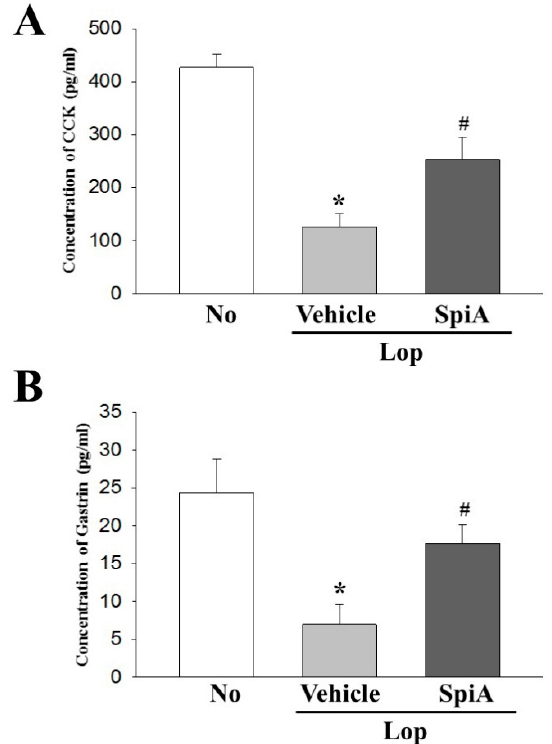
Figure 6. Alterations in the concentrations of CCK and gastrin in the colon of Lop + SpiA treated group. ( A ) The CCK concentration was measured in the colon homogenate by an enzyme-linked immunosorbent assay. The minimum detectable concentration of this kit is 0.1–1000 pg/mL CCK. ( B ) The gastrin concentration was measured in the colon homogenate by an enzyme-linked immunosorbent assay. The minimum detectable concentration of this kit is 0.312–20 pg/mL. Five-to-six mice per group were used in preparation of total lysate and hormone level was assayed in duplicate in each test. Data are reported as the mean ± SD. *, p < 0.05 compared to the untreated group. # , p < 0.05 compared to the Lop + Vehicle treated group. No, Untreated group; Lop, Loperamide; SpiA, Spicatoside A, CCK; Cholecystokinin.